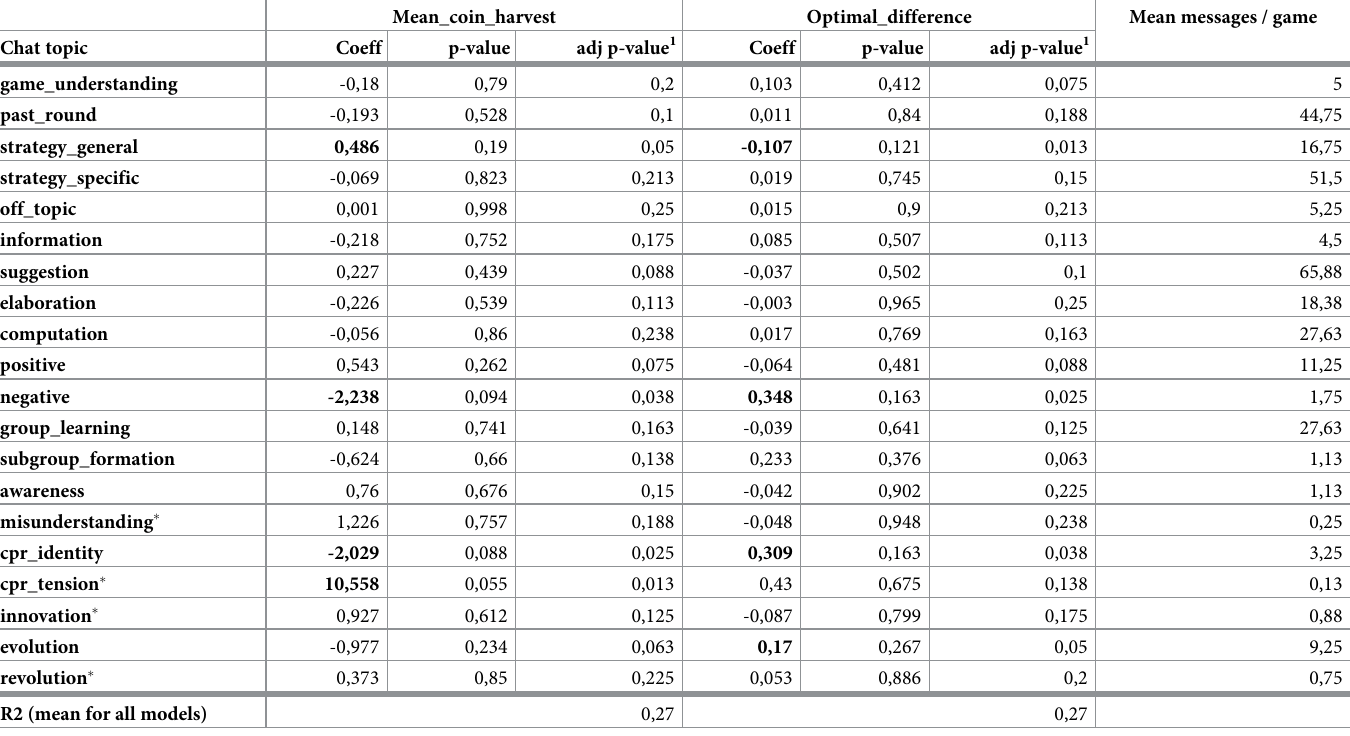
Table 4. Treatment C, the performance effect of the number of topical chat messages for any given